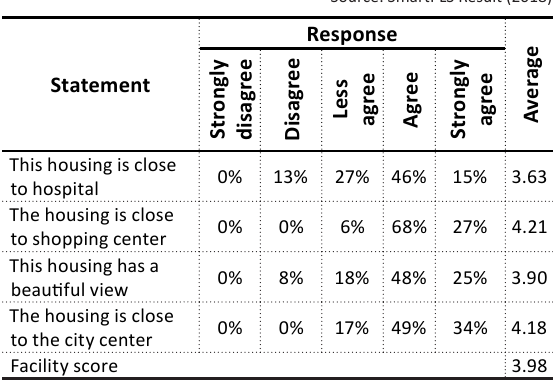
Table 5. Facility construct descriptive statistics